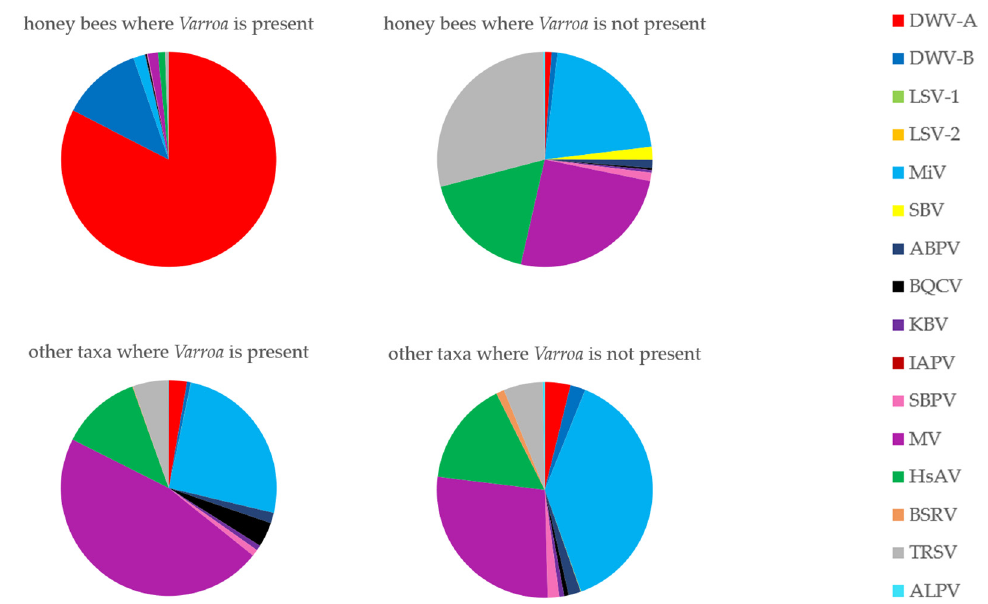
Figure 8. Pie charts showing compositions of the honey bee-associated viromes of honey bees and all other taxa sampled combined, from islands with and without Varroa .